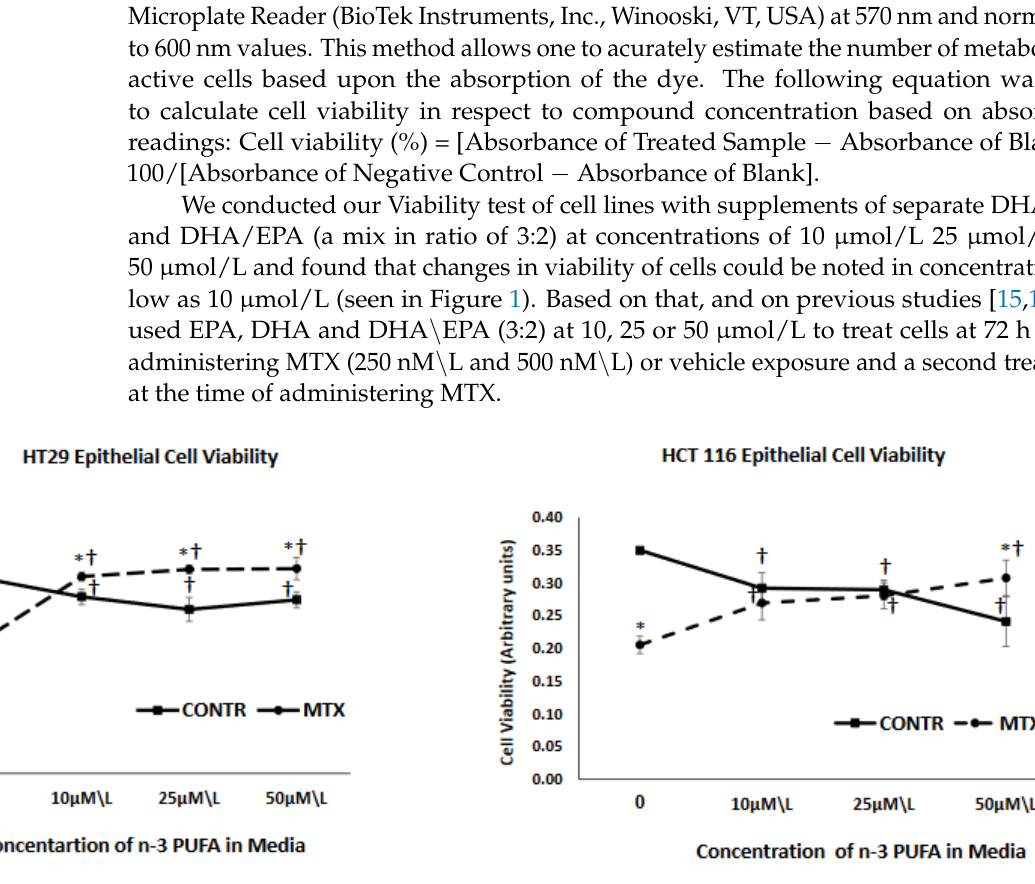
Figure 1. The effect of MTX and increasing concentrations of n-3 PUFAs on HT 29 and HCT 116 cell viability. PrestoBlue ® assay was used to evaluate cell viability. MTX-methotrexate, n-3 polyunsaturated fatty acids. Values are mean ± SEM. * p < 0.05 MTX-treated vs. MTX-non-treated cells, † p < 0.05 viability late vs.